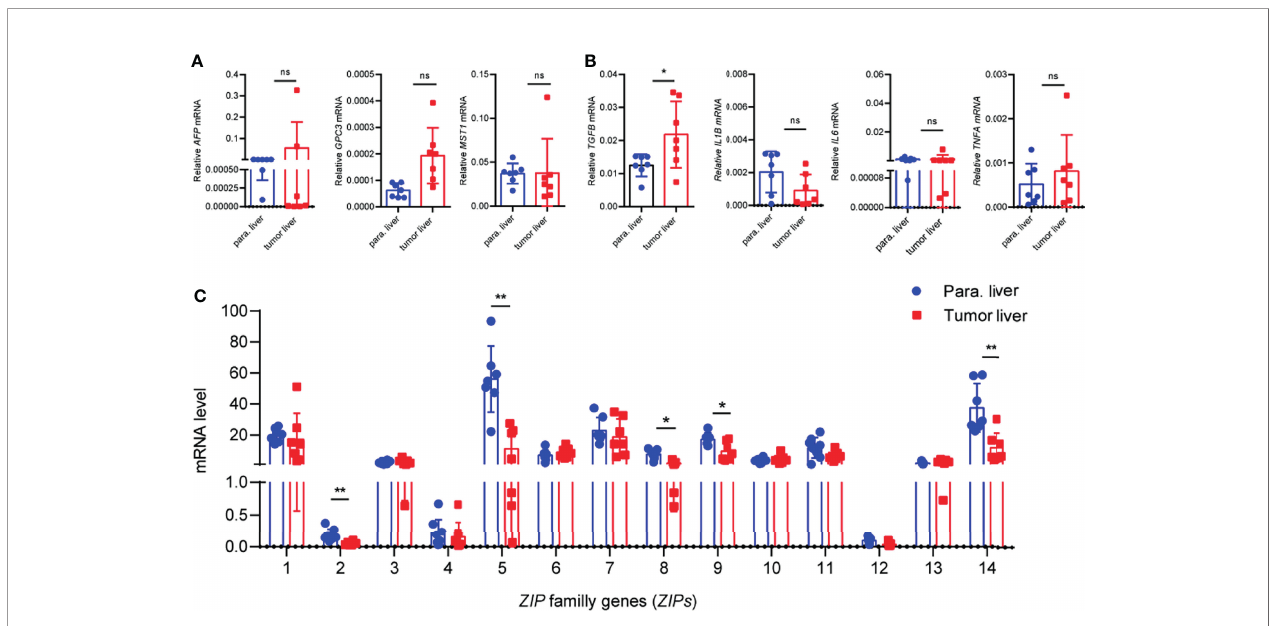
FIGURE 2 | The transcription patterns of ZIPs in human liver cancer tissues and paracarcinoma liver tissues. (A) The mRNA levels of AFP , GPC3 , MST1 were detected in human liver cancer tissues and paracarcinoma liver tissues by RT-PCR (n = 9). (B) In fl ammation-related gene TGFB , IL1B , IL6 , TNFA were measured in human liver cancer tissues and paracarcinoma liver tissues by RT-PCR (n = 9). (C) mRNA abundance pro fi les of ZIP s in human liver cancers and paracarcinoma liver tissues by RT-PCR (n = 9). The small circles represent the individual paracarcinoma liver tissues, and the squares represent the liver cancer tissues. The expressed values were calculated by the 2 − D CT value. * P < 0.05, ** P < 0.01, ns, not signi fi cant. The representative data from at least three independent experiments are shown. Data represent mean ± SD. By one-way ANOVA with Newman-Keuls or Holm-Sidak ’ s multiple comparisons test or Student ’ s t test.